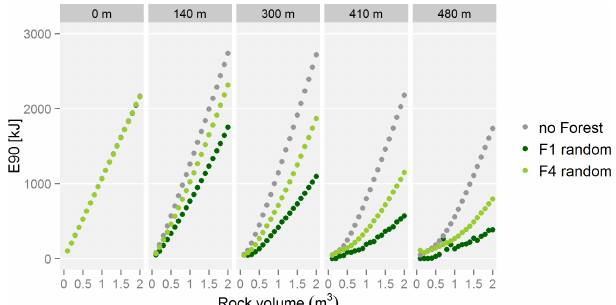
Figure 5. Illustration of the 90th percentile of maximum kinetic energies (E90) of blocks at different evaluation lines located at 0– 480m downslope of the release area based on 50 simulations per block. As before, results include a range of rock volumes from 0.05 to 2.0m 3 under forested (forest type 1 (F1): dark green; for- est type 4 (F4): light green) and non-forested conditions (grey) and with a random tree distribution, soil type 3 and rough slope condi-